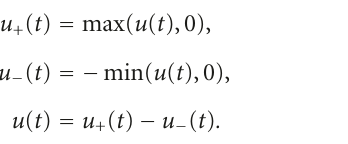
line shows the SNR when the perfect recovery algorithm of [1] with the sinc kernel K ( s , t ) = sin(2 Ω ( t − s )) /π ( t − s ), ( s , t ) ∈ R 2 , is used (other choices of sinc kernel bandwidth give similar or lower SNR). The cyan line represents the ( δ/σ ). Recovery in S 2 threshold SNR defined as 10log 10 outperforms recovery in S 1 but gives satisfactory results for a smaller range of the smoothing parameter. For a range of the regularization parameter λ both reconstructions outperform the performance of the recovery algorithm for bandlimited stimuli based upon the sinc kernel [1]. Finally, the stimulus recovery SNR is close to the threshold